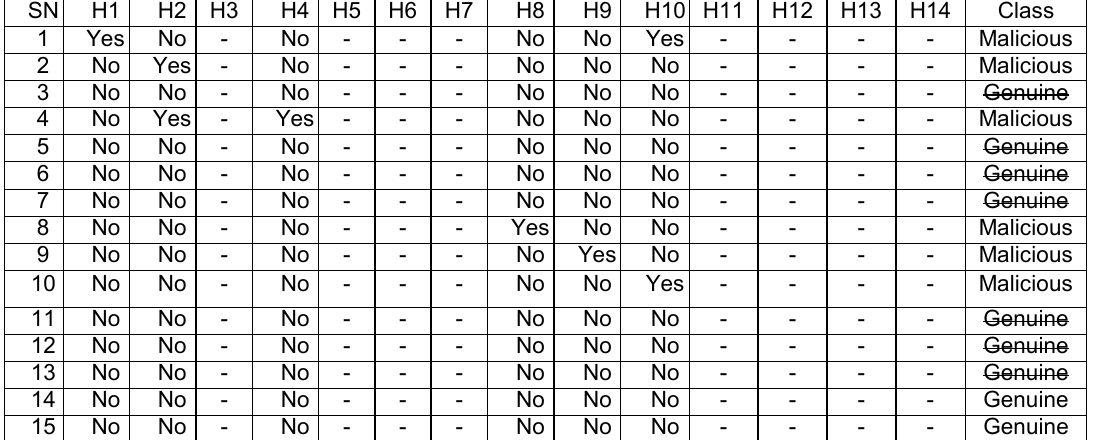
Table 3. Experimental Result of EPCMU Algorithm (existing approach)